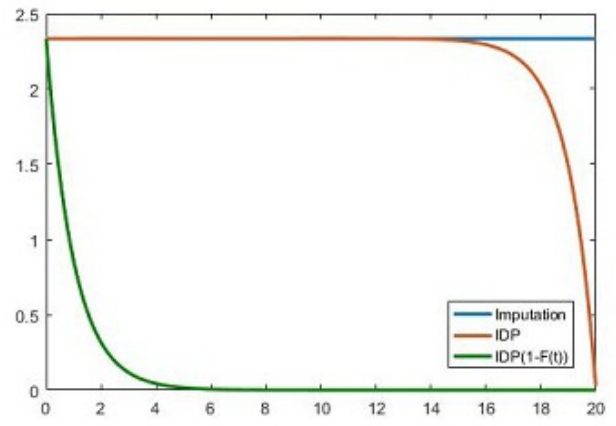
Figure 5. IDP and Imputation for one